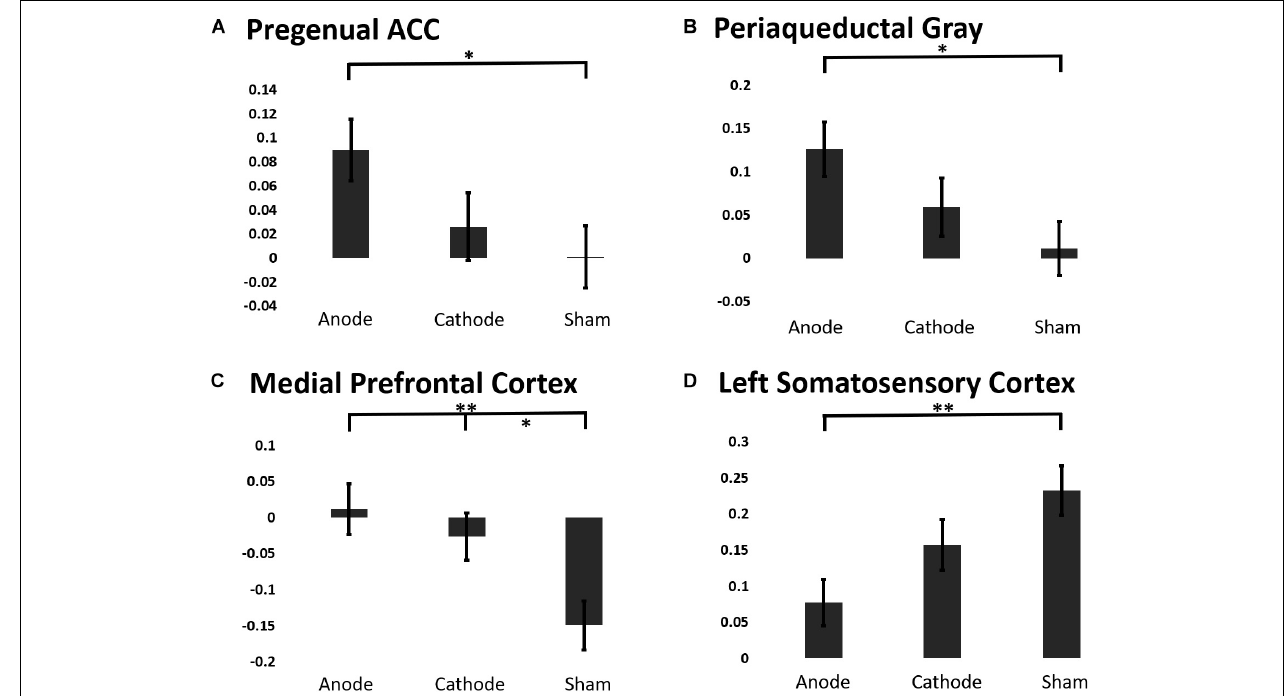
FIGURE 7 | The estimated marginal means of a region of interest analysis of post-treatment BOLD response linear mixed effects model controlling for baseline BOLD response to painful mechanical stimuli from ROIs in the (A) pACC, (B) PAG, (C) MPFC, (D) Left S1 ( ∗∗∗ p ≤ 0.001, ∗∗ p ≤ 0.01, ∗ p ≤